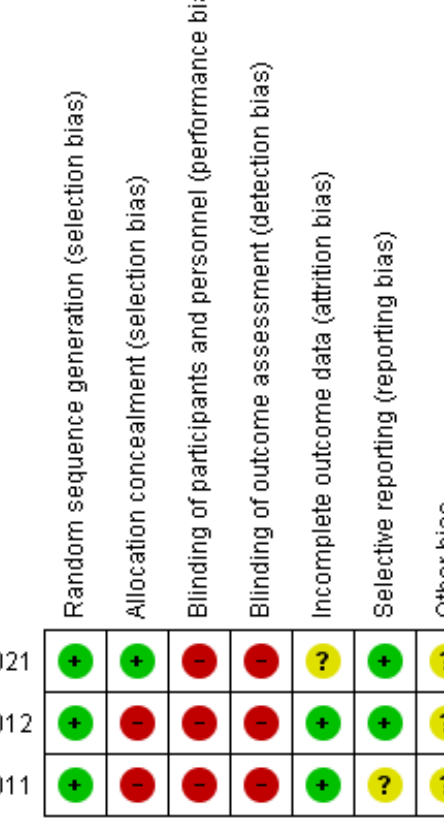
Figure 2. The risk-of-bias judgment of the RCTs, performed according to Cochrane Handbook for Systematic Reviews of Interventions: review authors’ judgements about each risk of bias item for each included study.